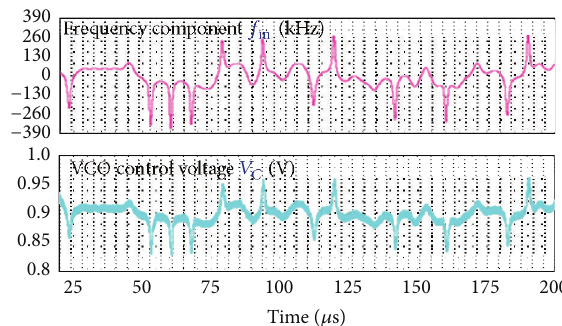
Figure 14: Simulated modulation performance of proposed archi- tecture for 8PSK.